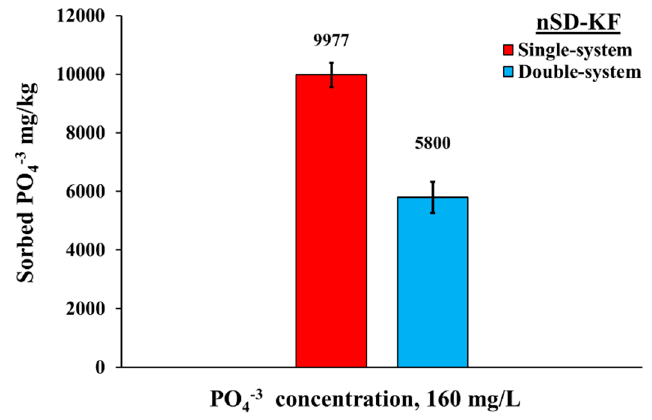
Figure 5. Phosphate removal in single and double-element systems by nSD-KF.